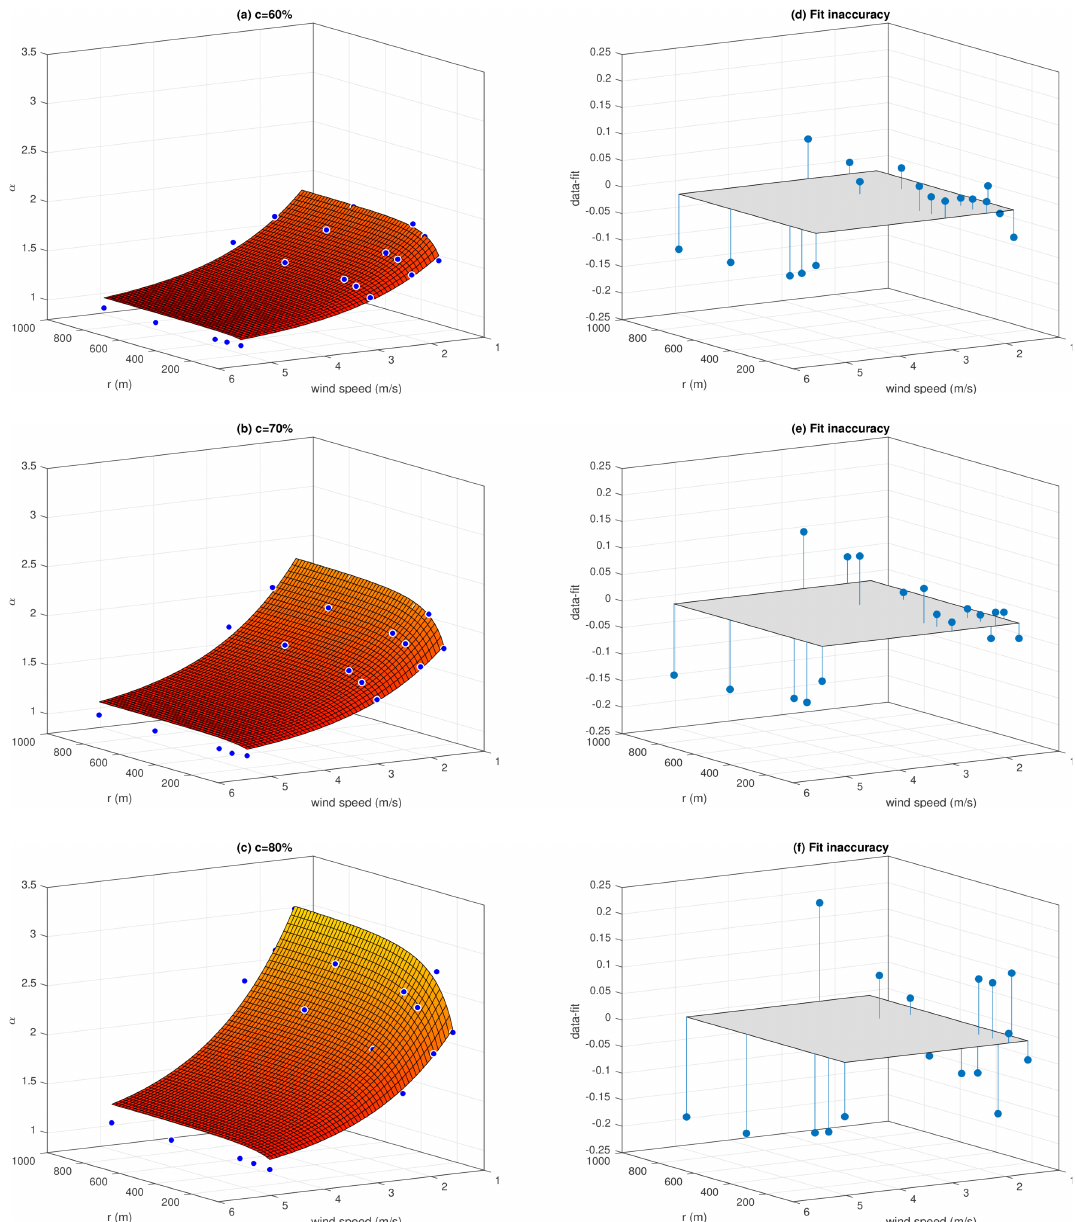
Figure 6. Left ( a – c ): values of α computed from Equation (9) (plotted surfaces) and obtained from WRF simulations (dots) for c = 60% ( a ), 70% ( b ) and 80% ( c ). Right ( d – f ): the accuracy of each fit represented by the difference between the original and fitted